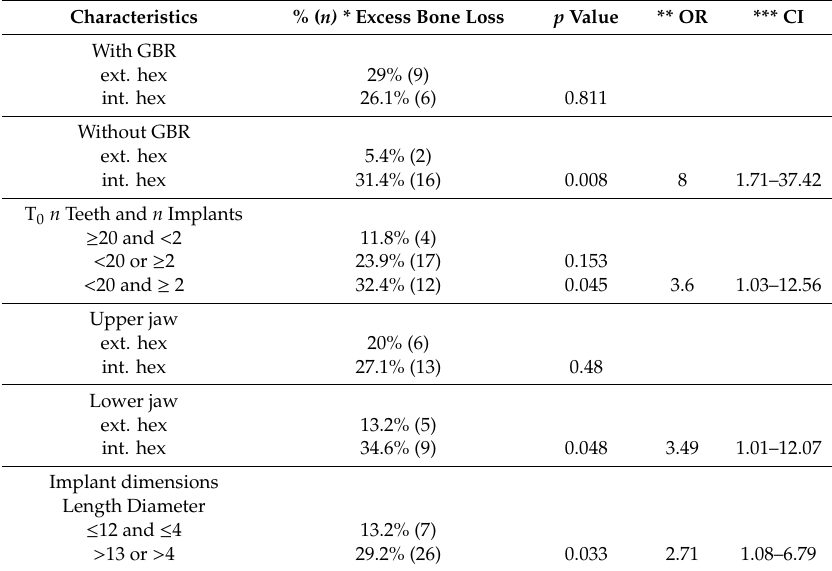
Table 4. Intervariable